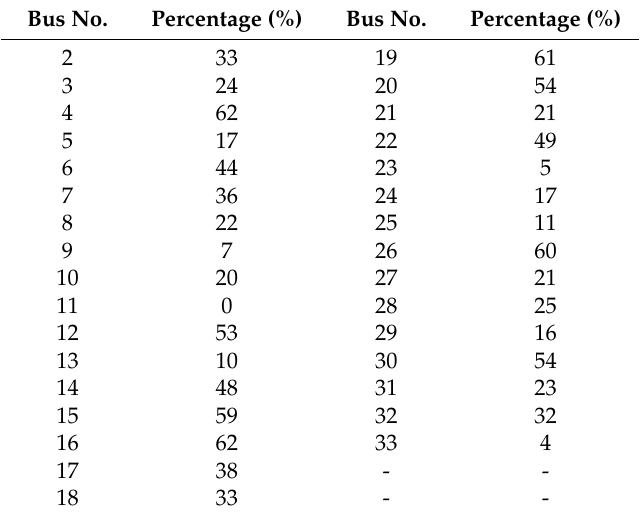
Table 2. The minimum percentage of load priority limit for each bus. Bus